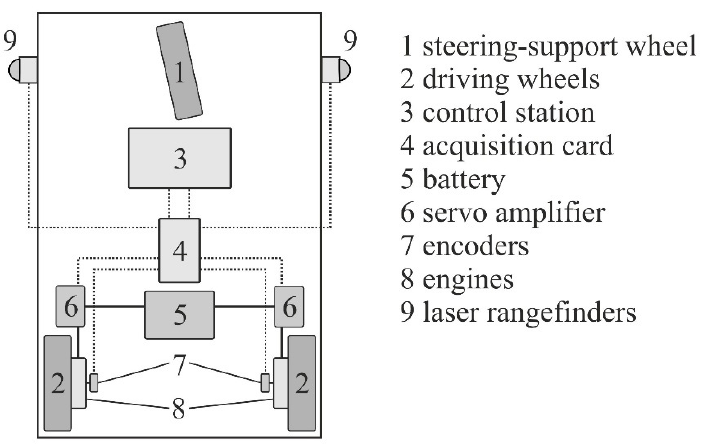
Figure 3. The scheme of the automated guided vehicle.